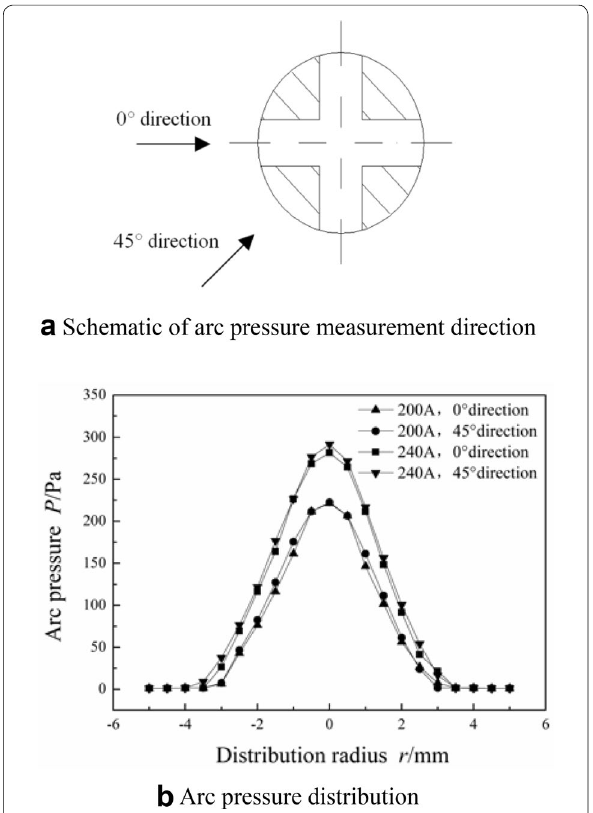
Figure 6 Arc pressures in different